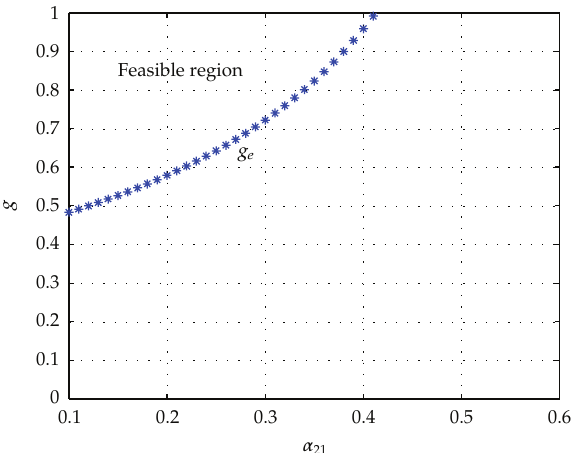
Figure 4: The theoretical immune feasible region g .